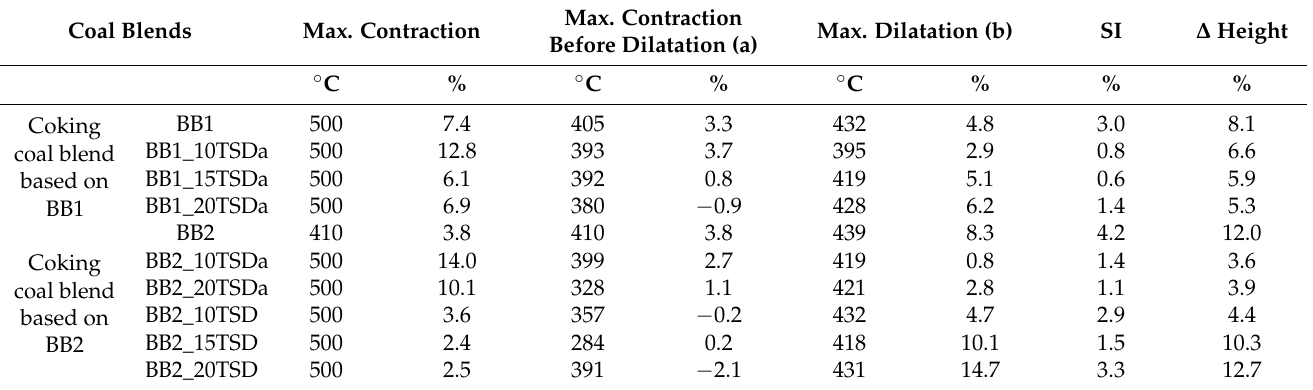
Table 3. Thermoplastic parameters determined by optical dilatometer tests for BB1 and BB2 with different addition of TSD and TSDa.